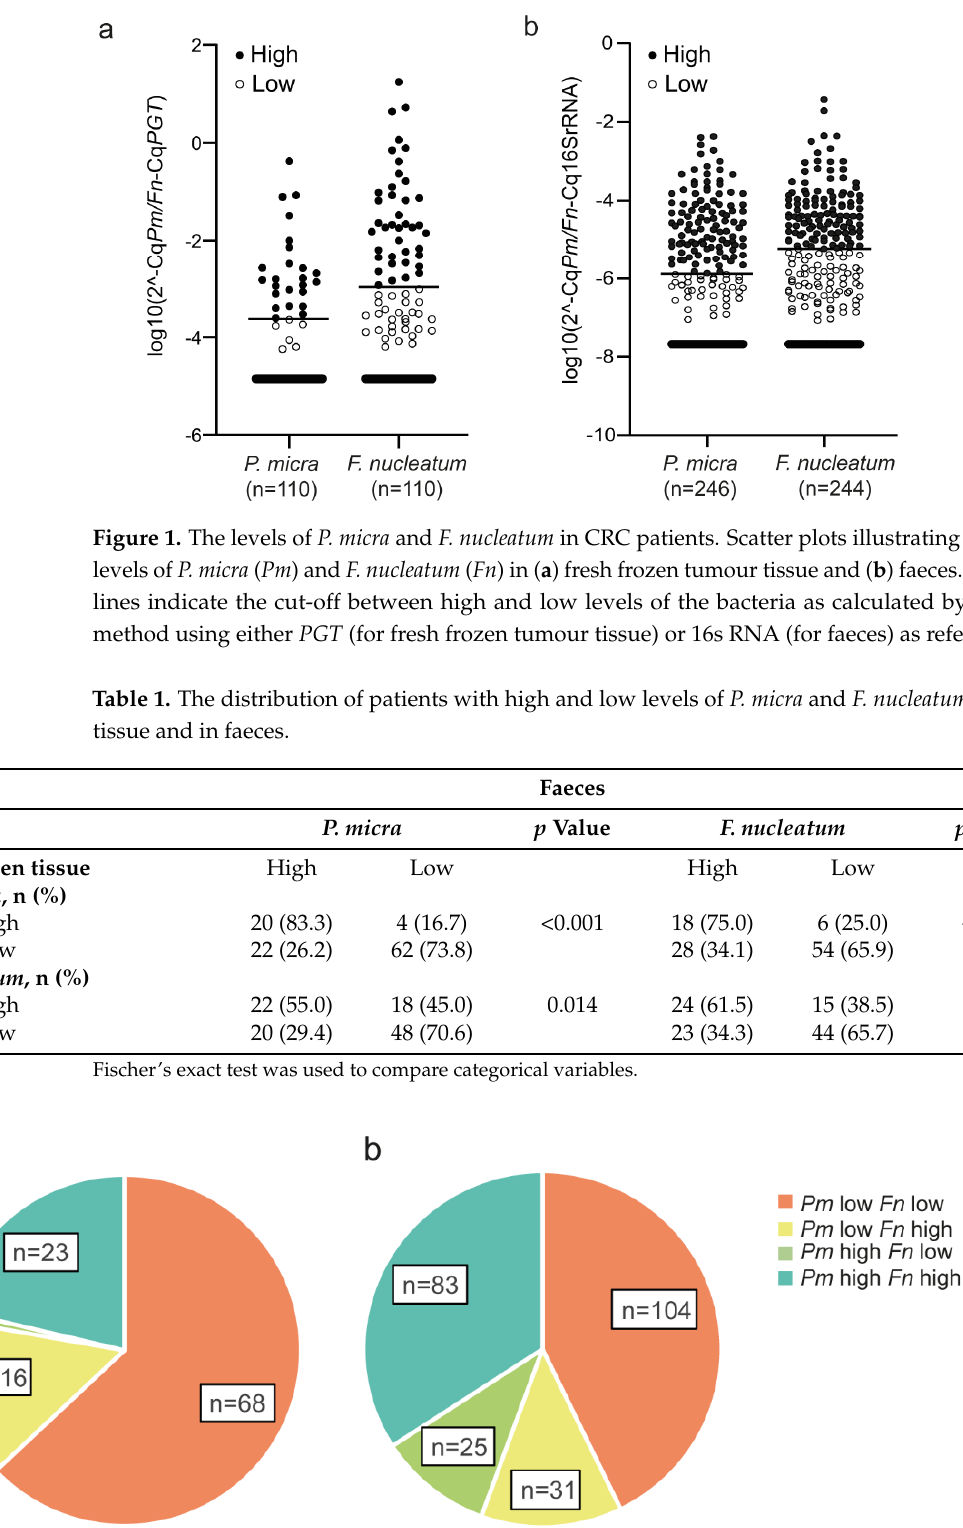
Figure 2. The relative distribution of P. micra and F. nucleatum in CRC patients. Pie charts are used to illustrate groups of patients with high or low levels of P. micra ( Pm ) and/or F. nucleatum ( Fn ) in ( a ) fresh frozen tumour tissue (n = 108) or ( b ) faeces (n = 243) of patients analysed for both microbial